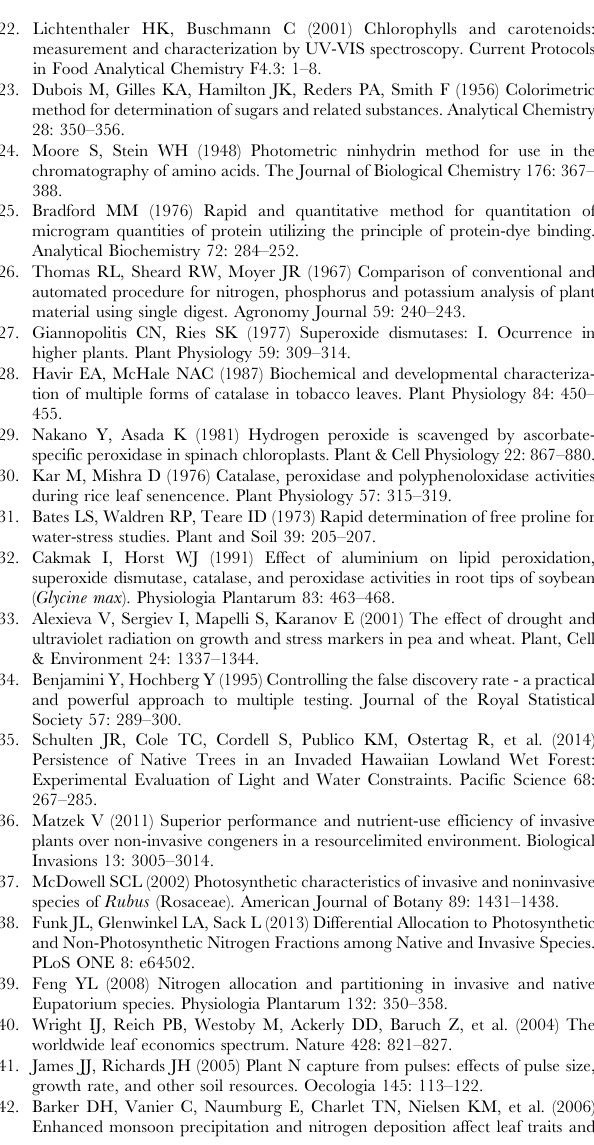
Table S1 This table contains original data for all biochemistry measurements. Table S2 This table contains original data for all nutrient measurements. Table S3 This table contains original data for all gas exchange